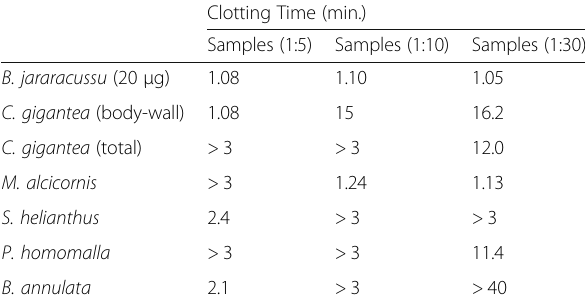
Table 1 Clotting activity inhibition from B. jararacussu snake venom by cnidarian extracts Clotting Time